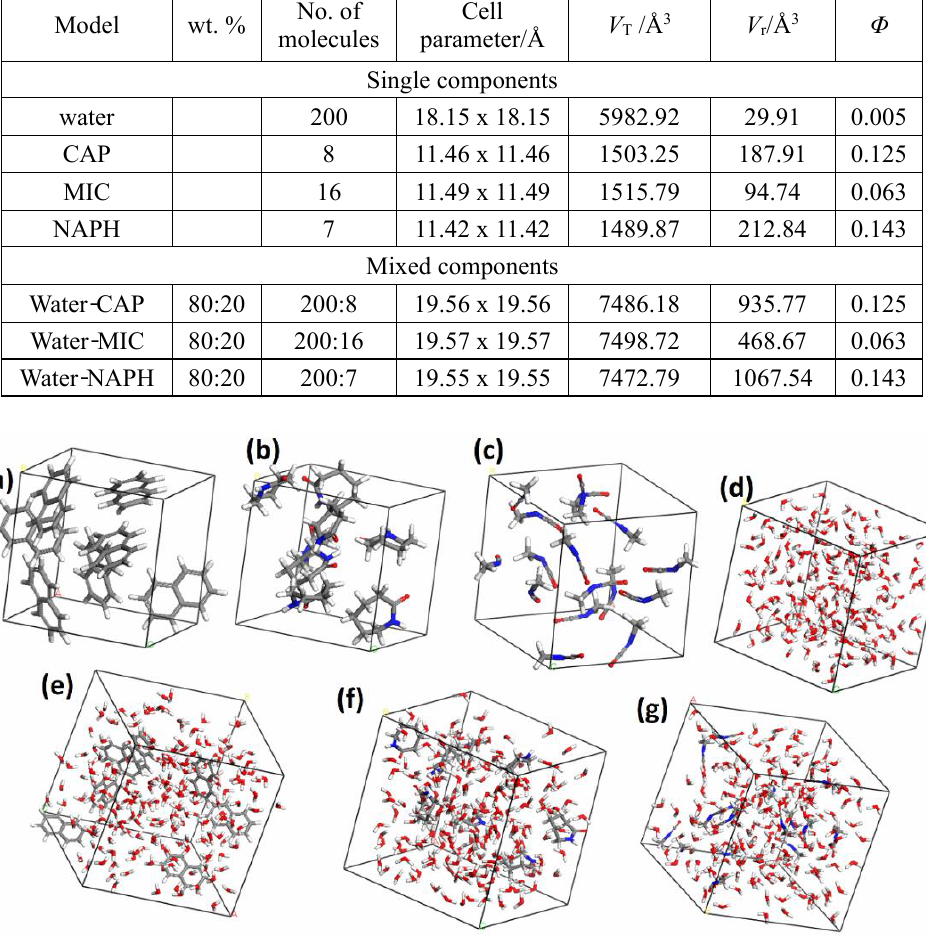
Table. 3 Parameters of the simulation models for solubility estimation